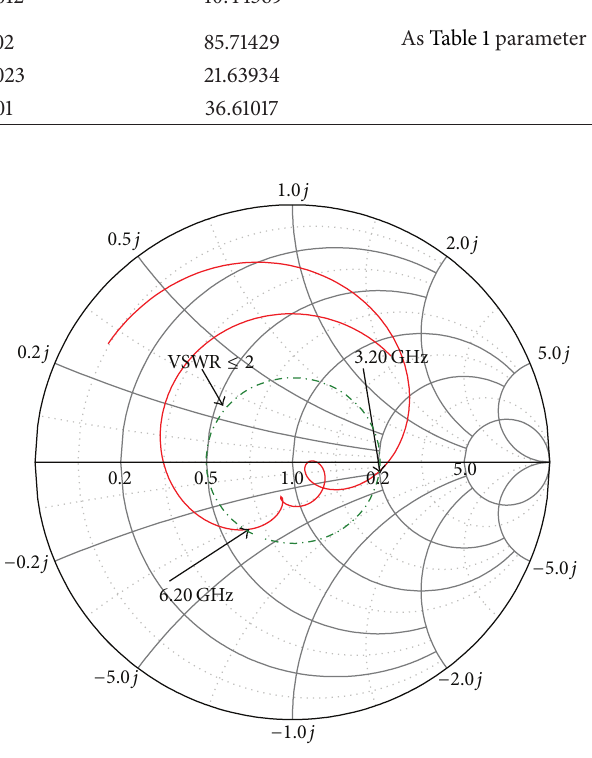
Figure 11: Smith chart of the proposed